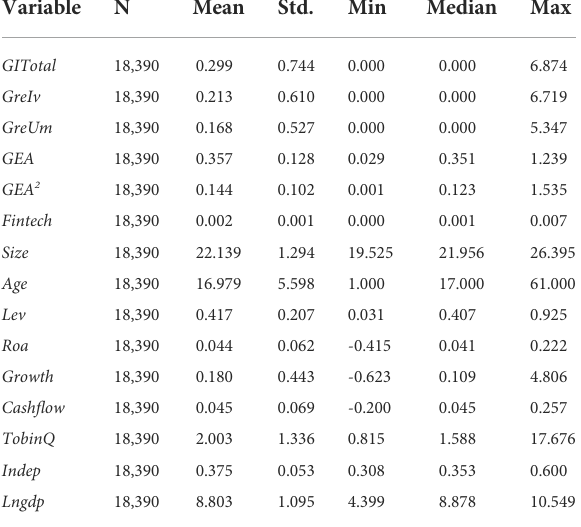
TABLE 1 Descriptive